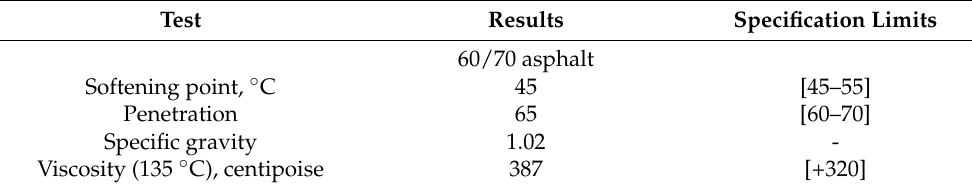
Table 2. Virgin and aged binder properties.